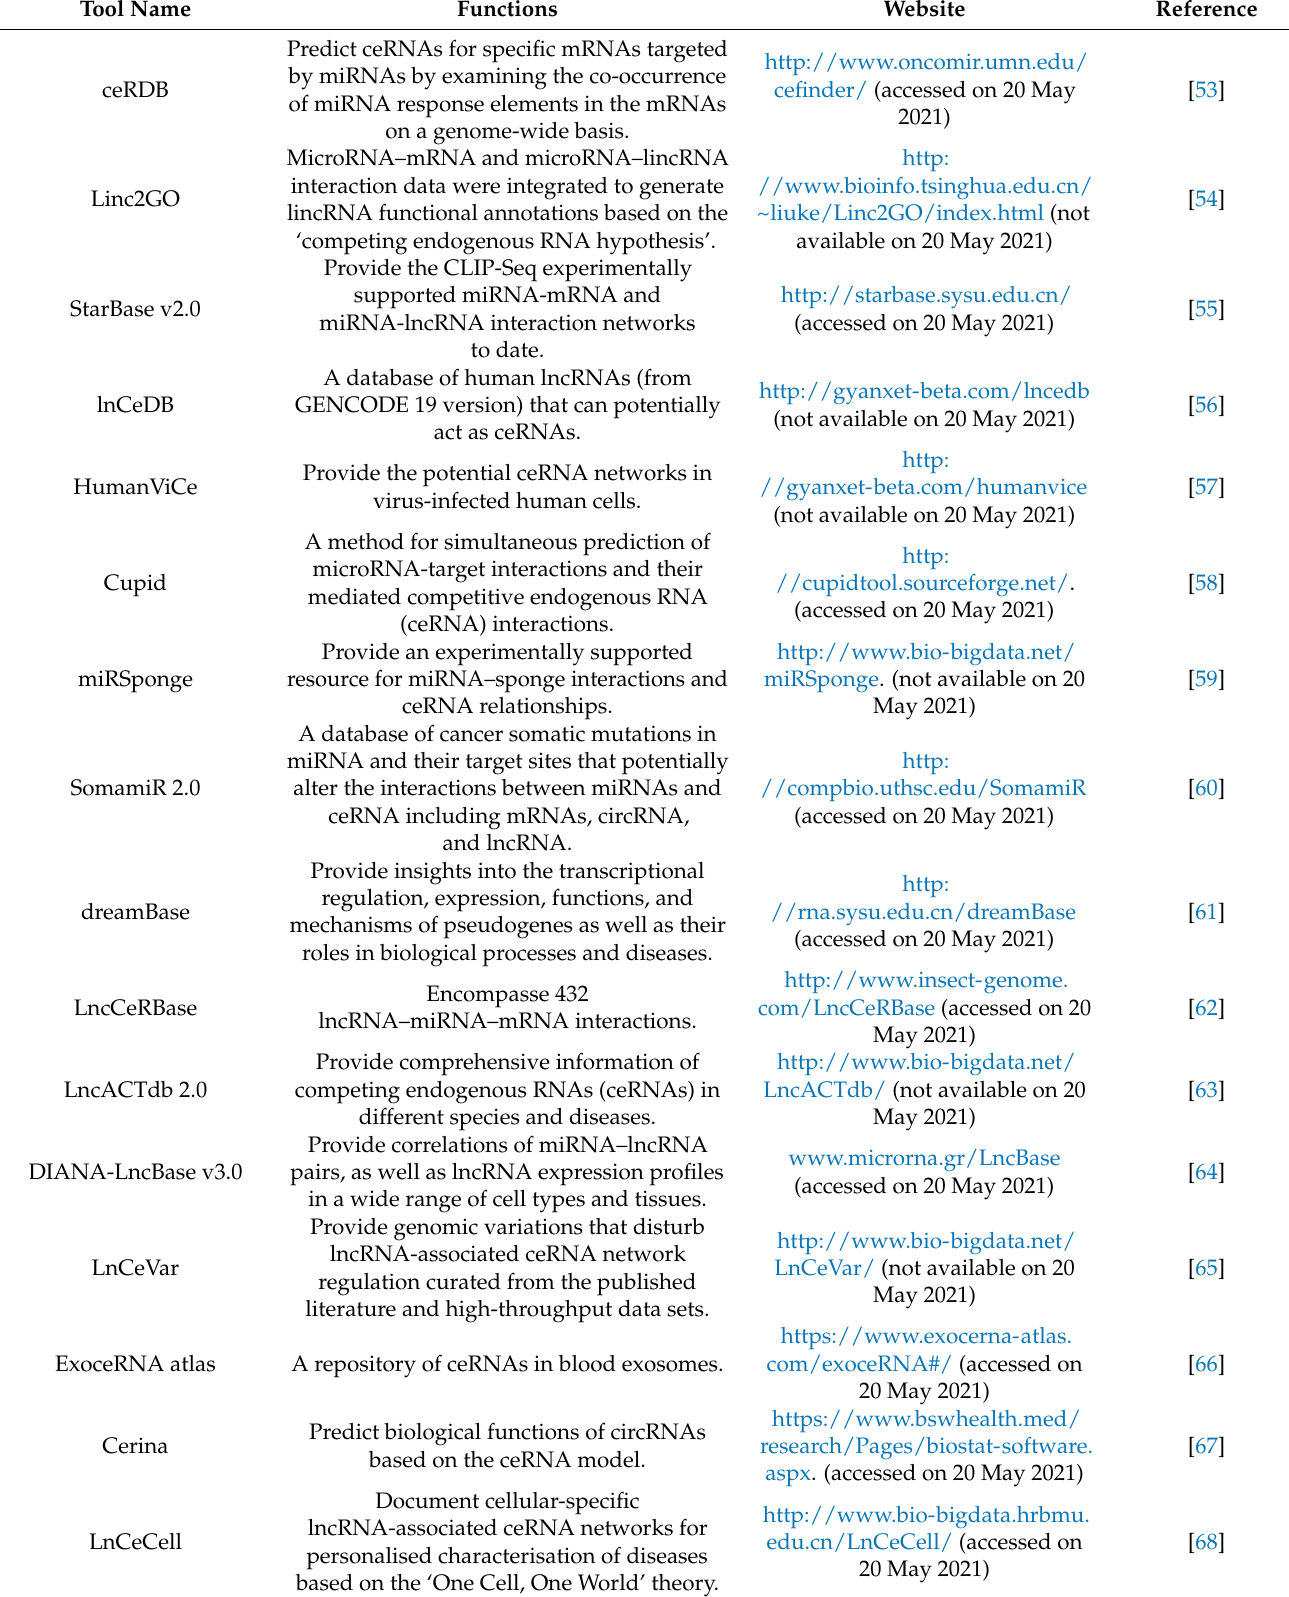
Table 1. Databases and resources for